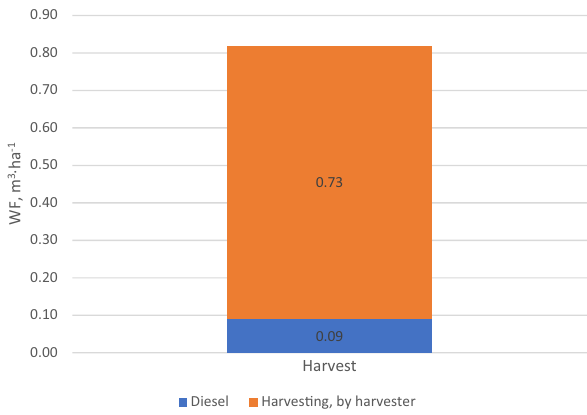
Figure 4. Water footprint related to carrot harvest in organic production (m 3 ha −1 ).